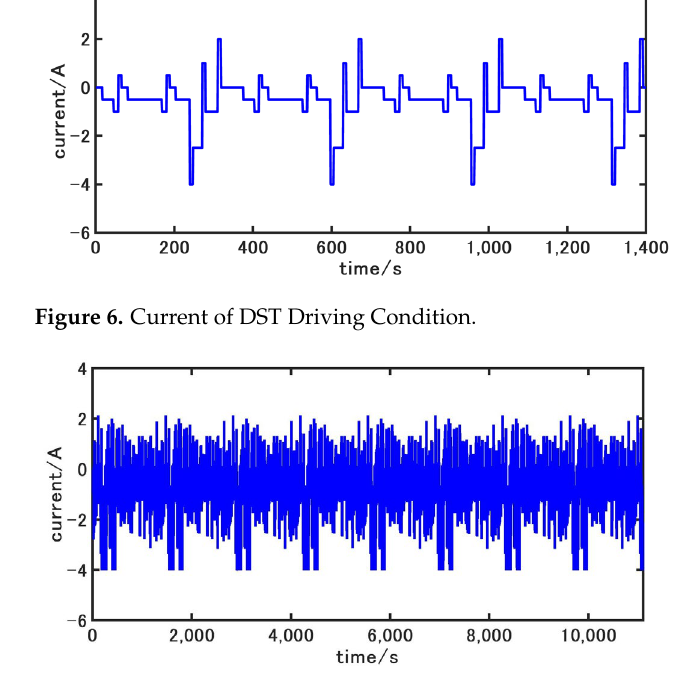
Figure 7. Current of FUDS Driving Condition.